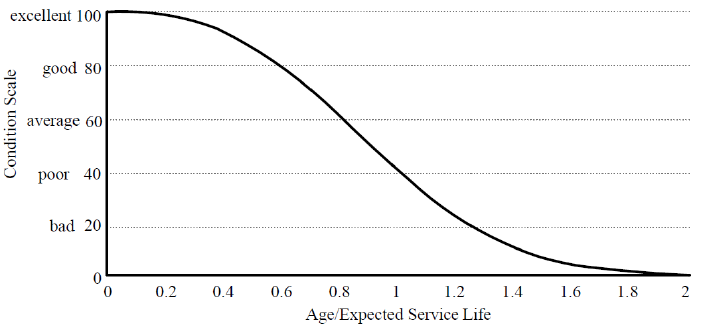
Figure 3. Condition index and age-based obsolescence curve. (Adapted with the permission of Reference [60]. Copyright 2014